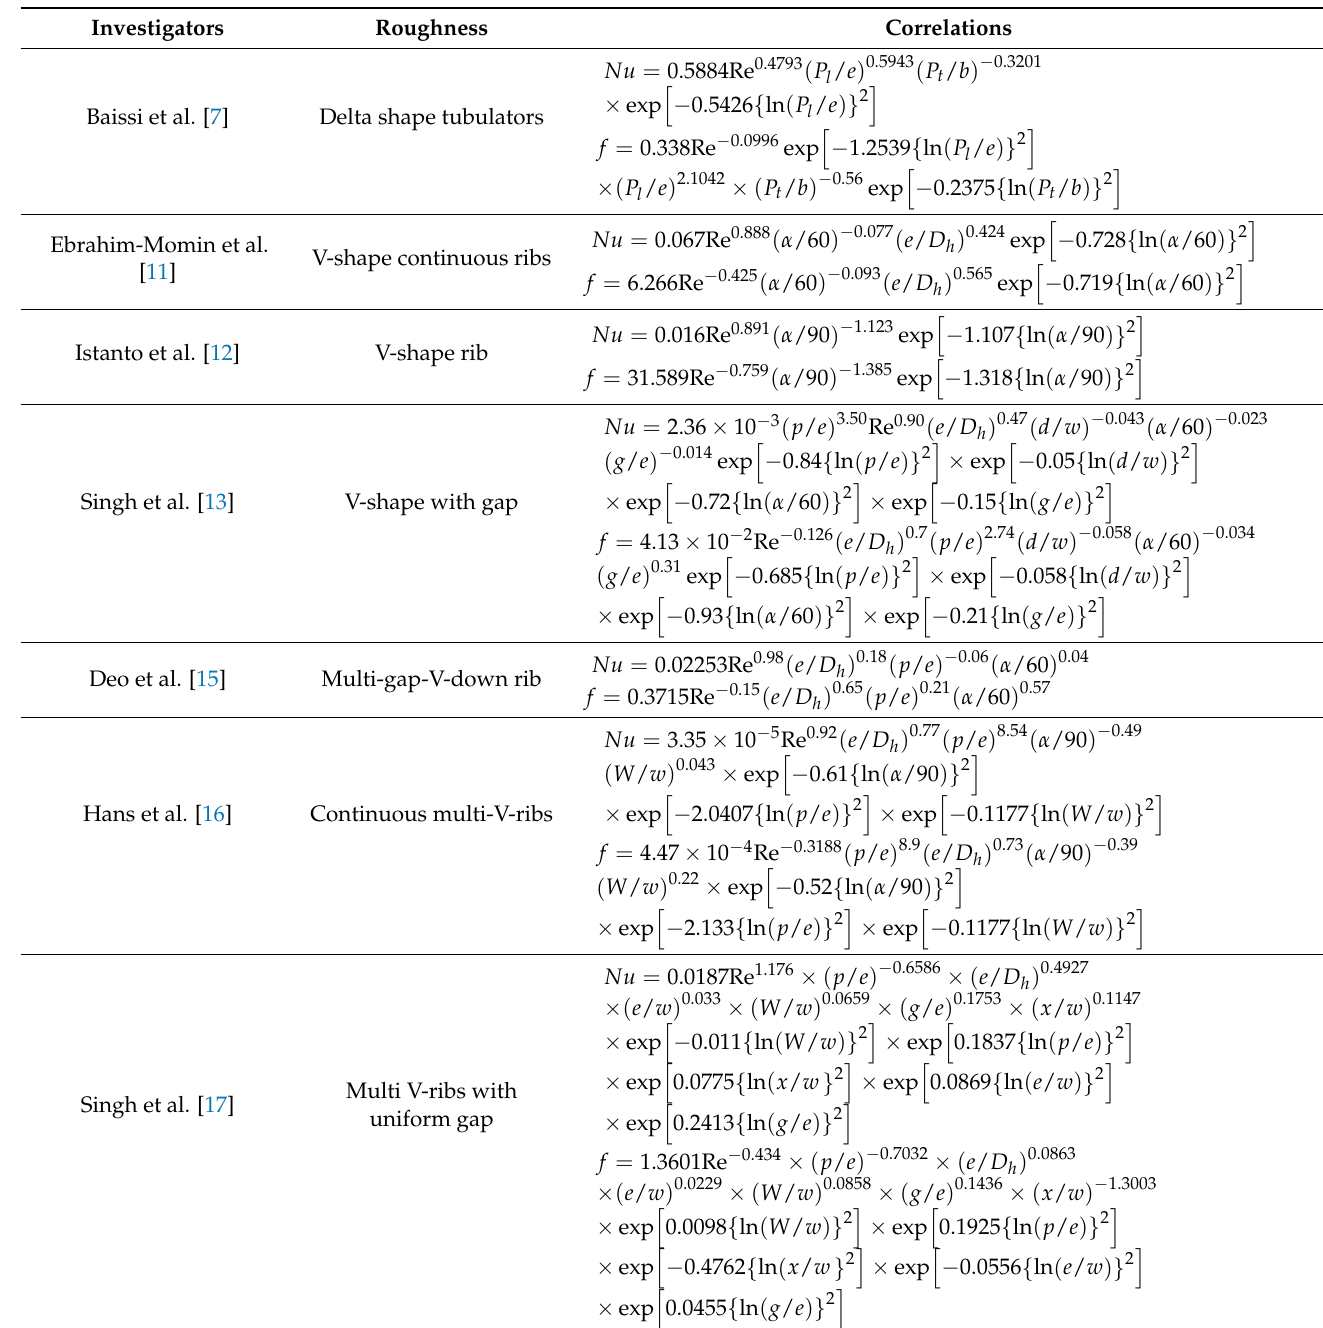
Table 2. Correlations developed by researchers for different roughened